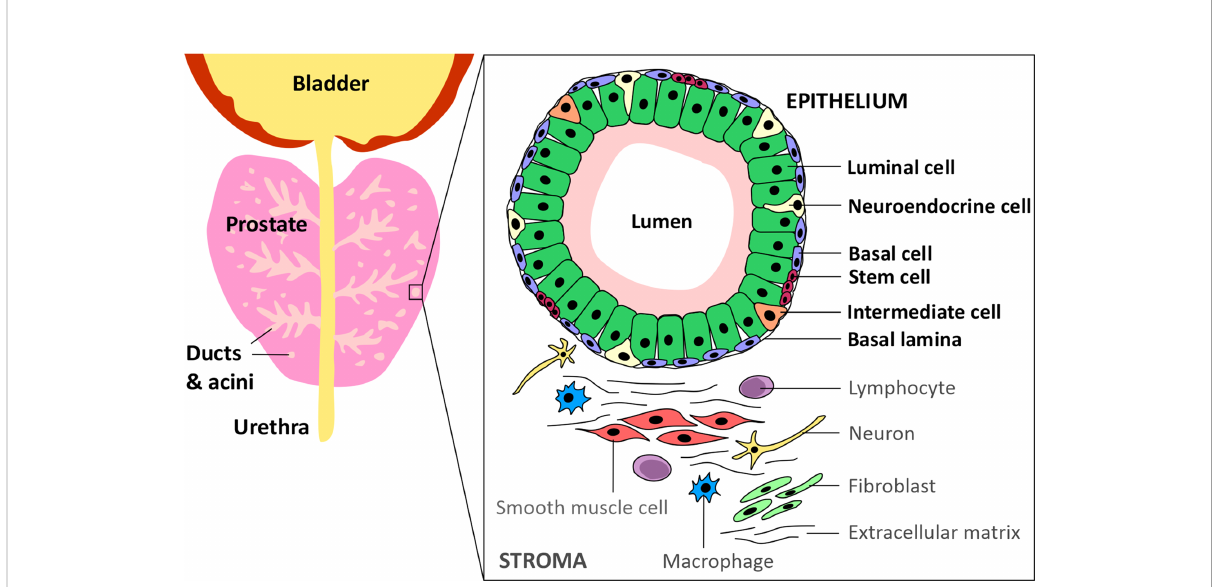
FIGURE 1 Schematic of the prostate epithelium and stroma. The prostate glandular structure is made up of ducts and acini. The epithelium that surrounds the lumen contains luminal, intermediate, basal, neuroendocrine and stem cells. The stroma contains extracellular matrix, immune cells, fi broblasts, neurons and smooth muscle